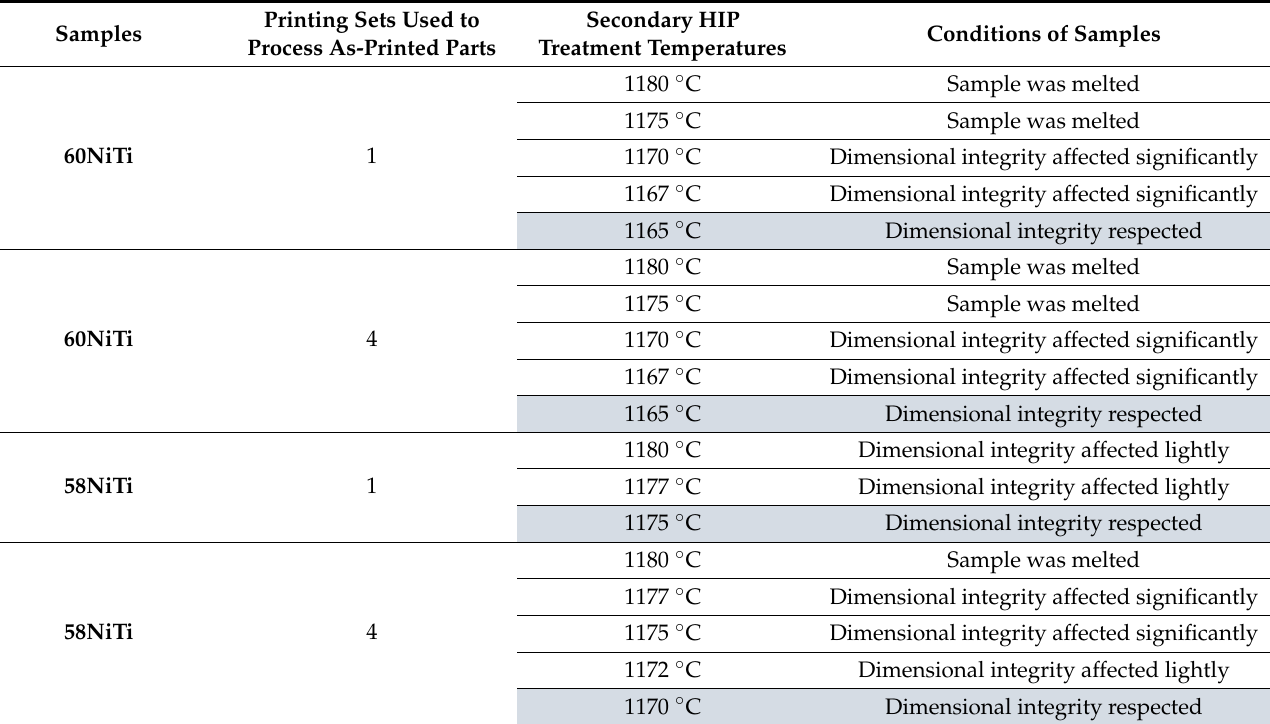
Table 4. Table showing the relation existing amongst the temperatures of applied secondary HIP treatments and dimensional integrities of processed 60NiTi and 58NiTi parts. Note, the highlighted parts show the temperatures at which the dimensional integrities of parts were